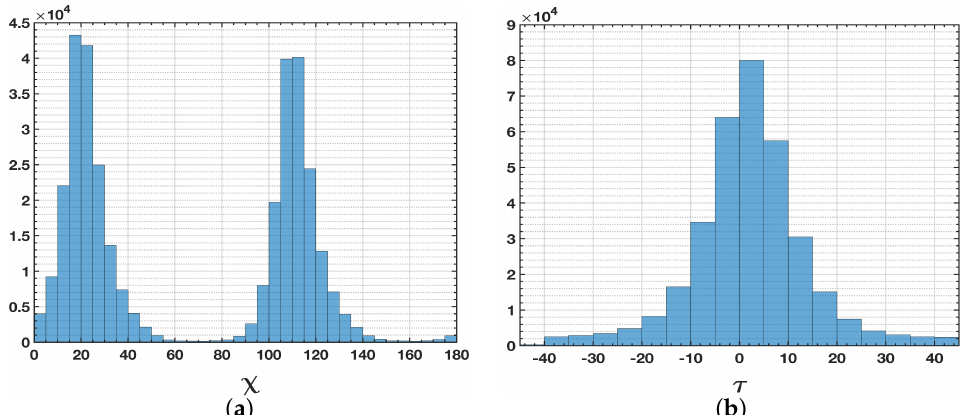
Figure 5. Histogram of characterized polarizations in the ESAR data set for the detection of single and double scatterers using the proposed method. ( a ) orientation angle, ( b )